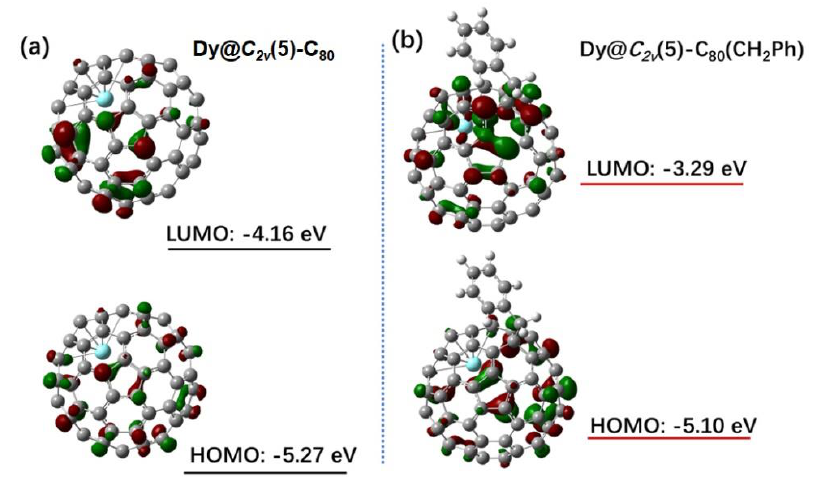
Figure 5. The electronic configuration (HOMO and LUMO energy levels) of ( a ) Dy@C 2v (5)-C 80 and ( b ) Dy@C 2v (5)-C 80 (CH 2 Ph) using density functional theory.